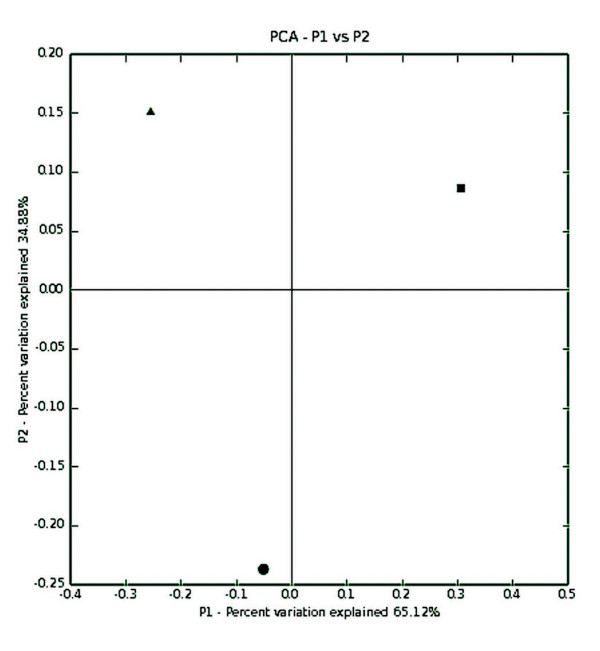
Principal components analysis ordination plot for the 16S rRNA gene. The percent of variation explained by each principal component is indicated on the axis labels. Ecosystems are represented by the following symbols: AmF ■, AtF ●, and BS ▲.